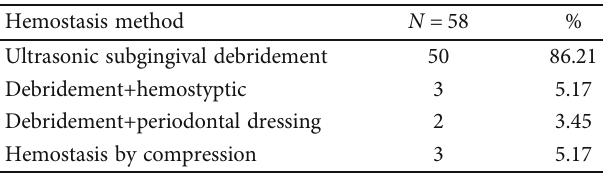
Figure 3: 12 distal angular absorption. Table 5: Hemostatic